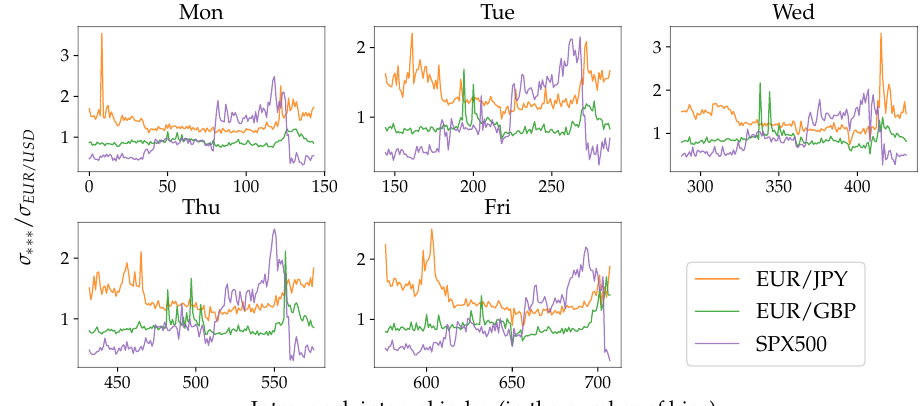
Figure A1. Daily realised volatility ratio of BTC/USD measured over 10-min time intervals dissecting the entire week into 1008 bins. The volatility is computed according to the “traditional” approach (Equation (20)).